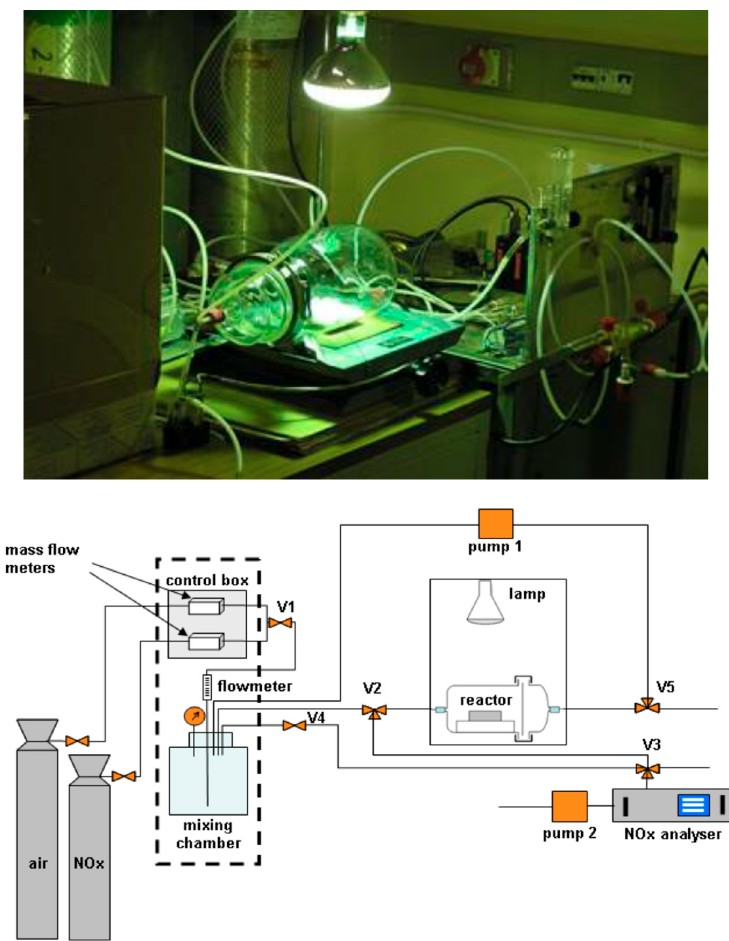
Figure 32. ( top ) Indoor reactor used to measure NO x abatement using the TX-Active photocatalytic TiO 2 –based cementitious substrate Photograph reproduced from Borgarello Ref. [121]. ( bottom ) Schematic of the flow-through reactor assembly; reproduced from Guerrini and Peccati [123].